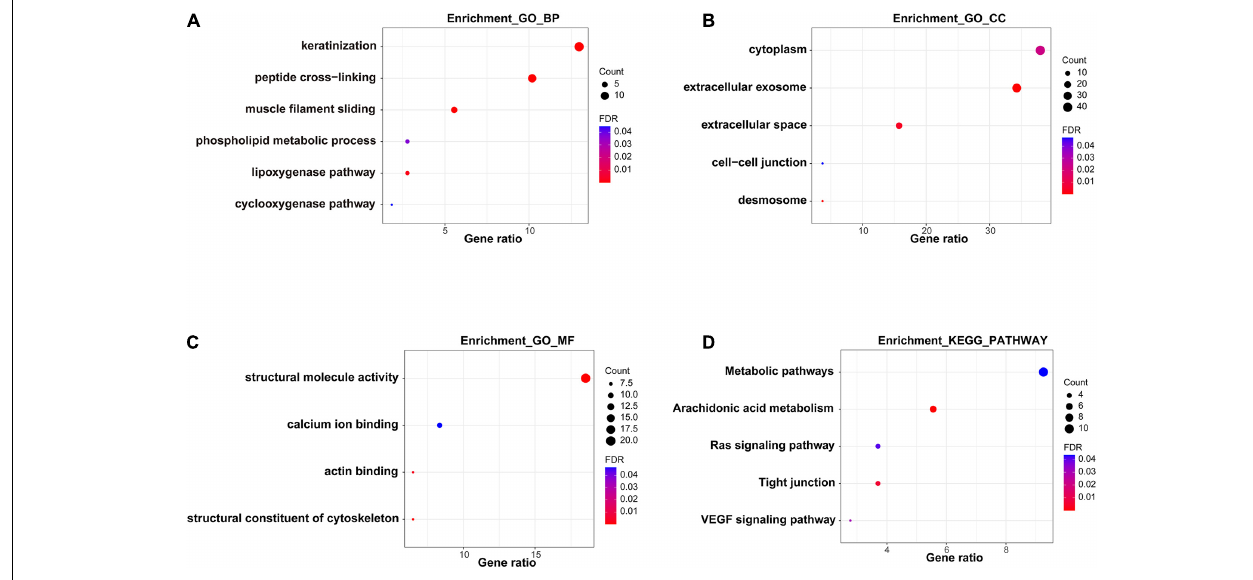
FIGURE 3 | Functional enrichment analysis of DEGs. (A–C) GO analysis of DEGs. (D) KEGG pathway analysis of